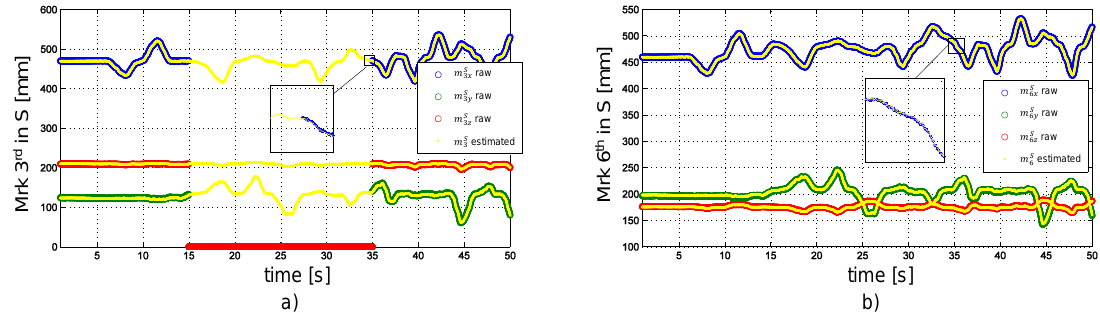
Figure 3. ( a ) Marker 3rd is invisible in 20 s and ( b ) Marker 6th is visible. Estimated marker position based on the complementary filter in x, y and